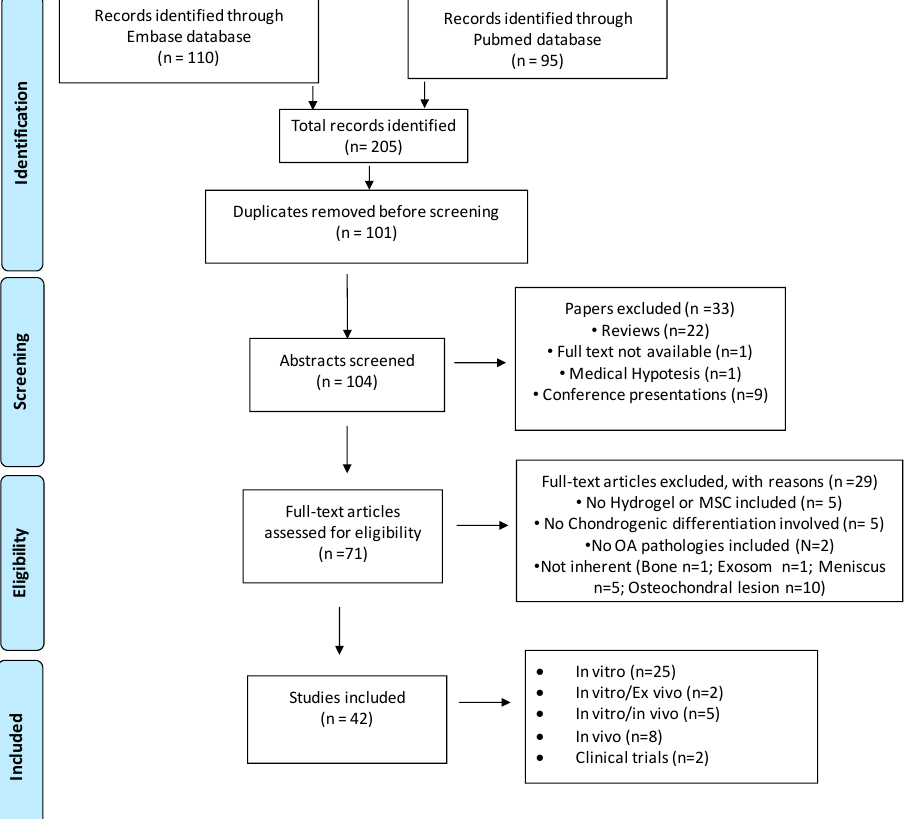
Figure 1. Search strategy according to Preferred Reporting Items for Systematic reviews and Meta- Analyses (PRISMA) guidelines and number of records found and included.